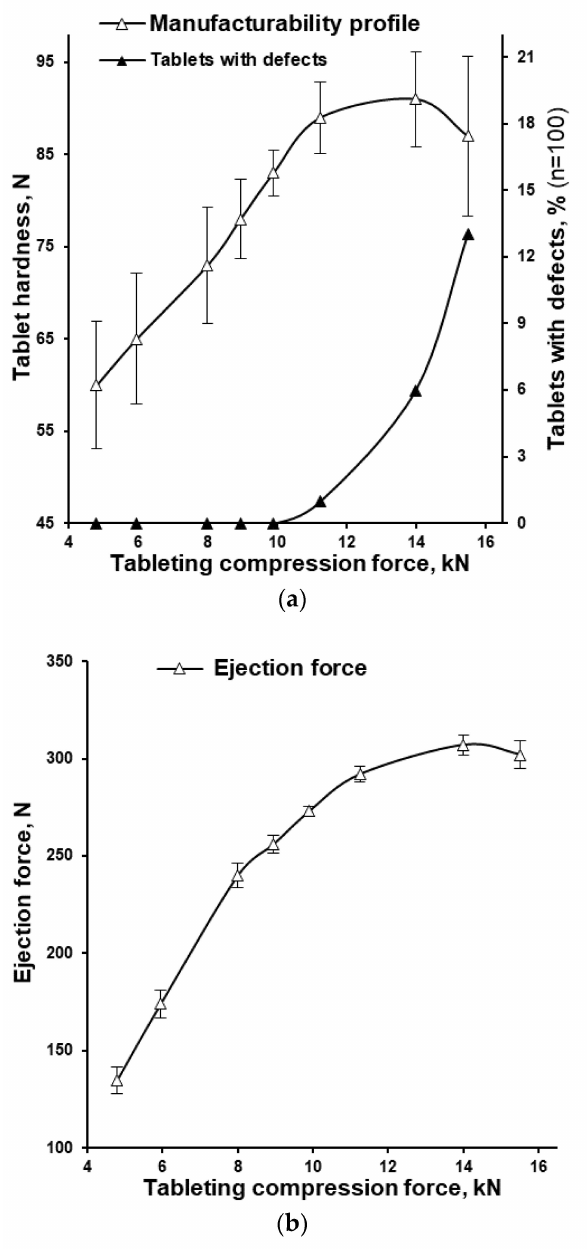
Figure 7. Effect of tableting compression force on: ( a ) the tablet hardness (Manufacturability profile; n = 20) and percent of tablets with defects after friability test ( n = 100); ( b ) the tablet ejection force from the die ( n =